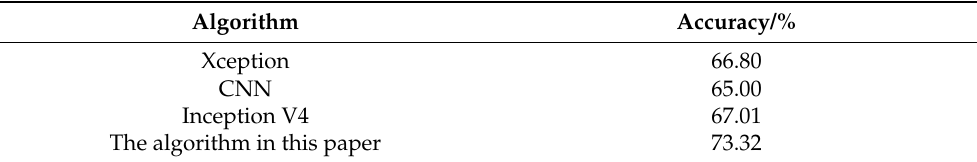
Table 7. Recognition accuracy of different methods on fer2013.